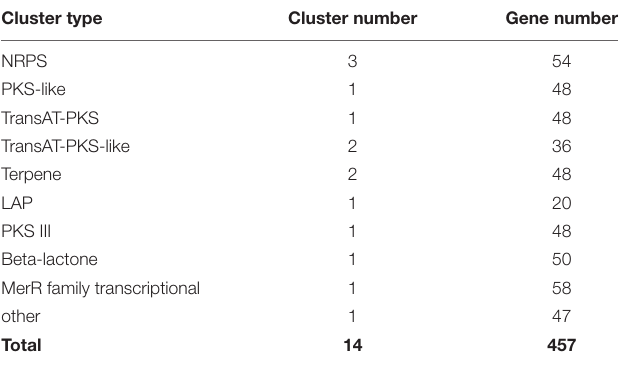
TABLE 3 | Cluster number and gene number shown in different cluster